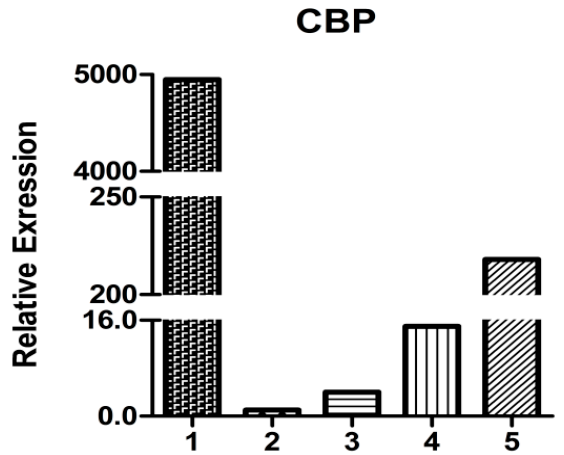
Figure 7. Relative expression of HpCBP45 in different